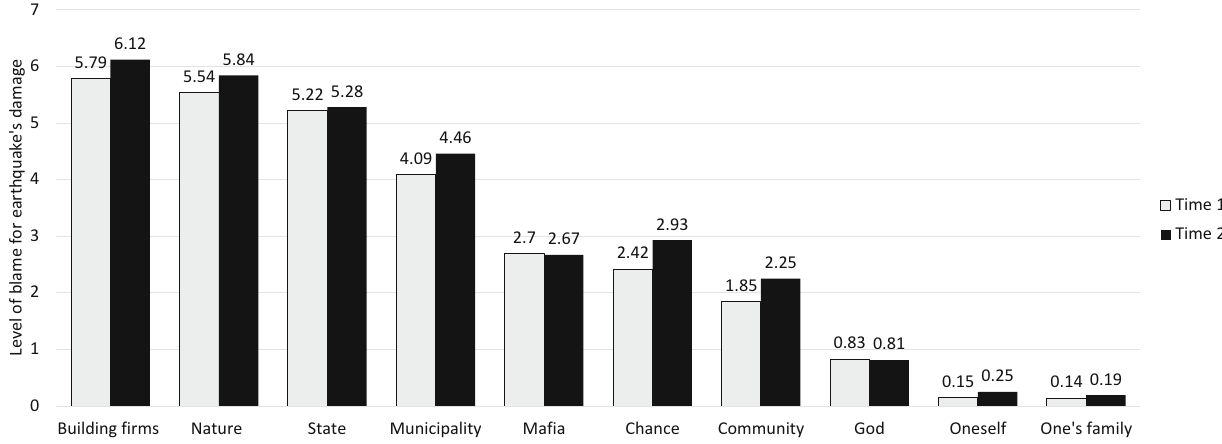
Fig. 3 Levels of blame for earthquake damage in the Amatrice, Central Italy, study after the 2016–2017 earthquakes. Mean attributions rating for each entity at Time 1 and Time 2, where 0 = not blameworthy at all and 9 = extremely blameworthy